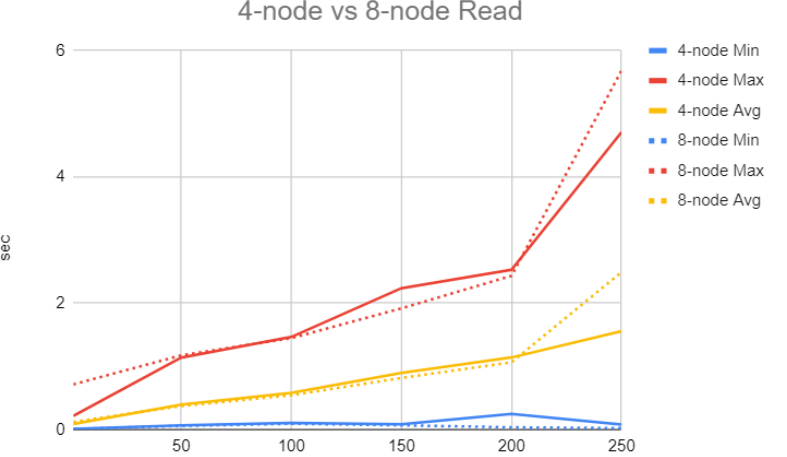
Figure 7. Latency of read TXs (in seconds) measured with different Indy-based BC network sizes and different arrival